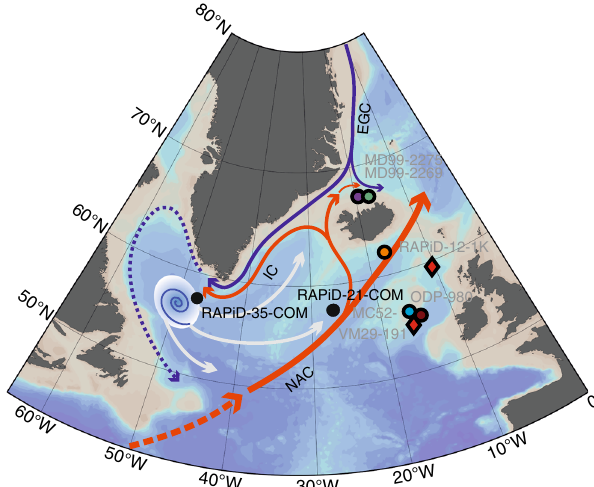
Fig. 1 Sediment core location and regional ocean circulation. Red arrows indicate the warm and salty waters originating from the North Atlantic Current (NAC) fl owing west as the Irminger Current (IC). Cold and fresh polar waters from the East Greenland Current (EGC) are indicated by the dark blue arrows, the dotted blue arrow indicates the West Greenland Current. The locus of Labrador Sea Water (LSW) formation is indicated by the blue spiral and the white arrows indicate the spreading of LSW through intermediate depths to the Irminger and Iceland Basins and to the lower latitudes. New reconstructions used in this study are shown in black and location of published proxy records presented in Figs. 2 and 3 are colour- coded and labelled in grey. Unlabelled red diamonds show the locations of the deep sea corals from ref. 42 . Bathymetric basemap made using ODV (Schlitzer, R., Ocean Data View, https://odv.awi.de,